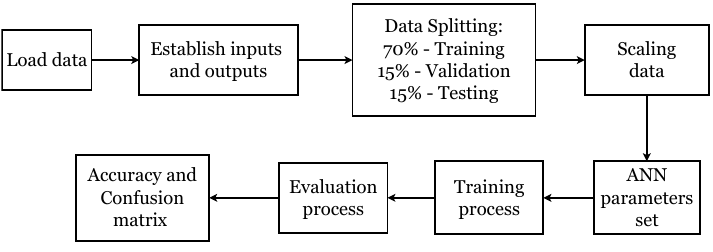
Figure 3. ANN algorithm for SF classification.